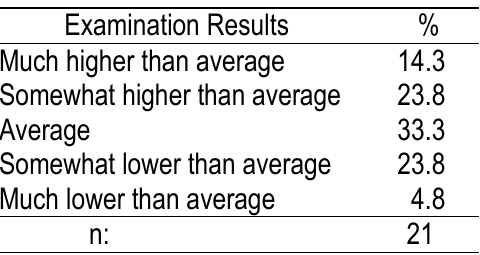
Table 2. Mid-term examination results of the